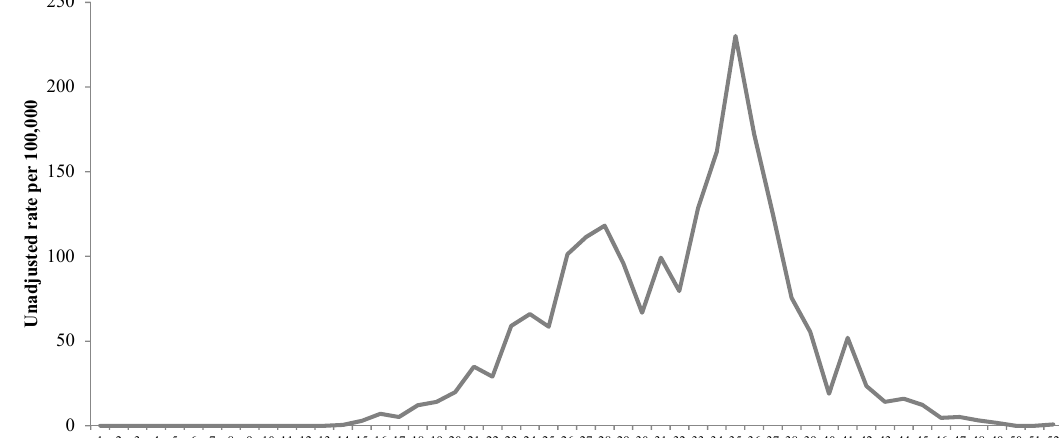
Figure 1. Unadjusted incident rate (per 100,000) of chikungunya virus infection among affiliates to the Mexican Institute of Social Security ( IMSS from its Spanish acronym) in the state of Colima, Mexico, 2015.